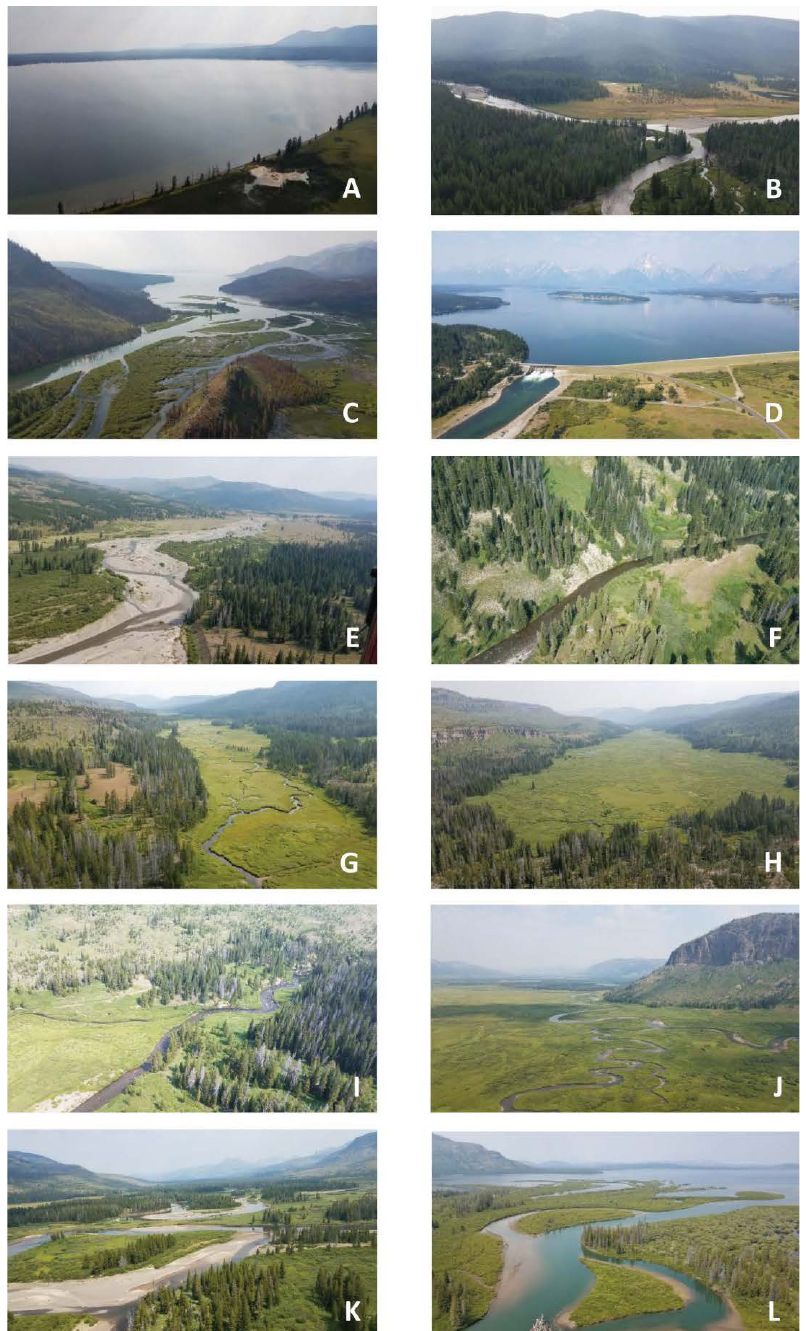
Figure 4. Connected waters of the upper Snake and Yellowstone River systems in Yellowstone National Park, Grand Teton National Park, and the Bridger-Teton Wilderness in northwestern Wyoming, including ( A ) Lewis Lake; ( B ) the confluence of the Lewis and Snake rivers; ( C ) Snake River confluence with Jackson Lake; ( D ) Jackson Lake and dam; ( E ) lower Pacific Creek; ( F ) middle Pacific Creek; ( G ) upper Pacific Creek; ( H ) Two Ocean Pass and the confluence of North Two Ocean Creek with Pacific and Atlantic creeks; ( I ) middle Atlantic Creek; ( J ) the confluence of Atlantic Creek and the Yellowstone River; ( K ) Yellowstone River upstream of Yellowstone Lake; and ( L ) Yellowstone River confluence with Yellowstone